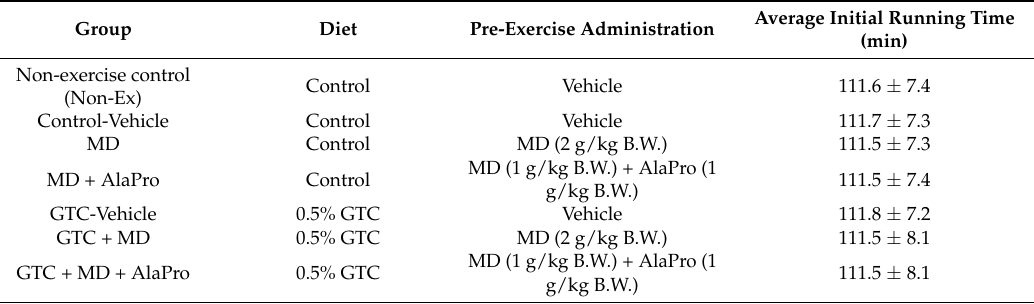
Table 1. Experimental